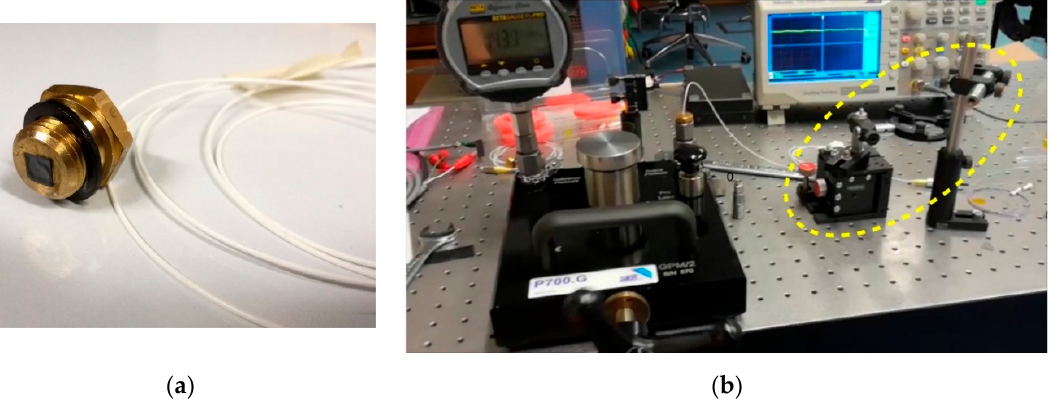
Figure 8. ( a ) Picture of a diamond-on-silicon membrane mounted on the brass holder and coupled to the SMF. ( b ) Picture of the experimental set-up used during high-pressure membrane characterization. On the left, the hydraulic test pump with the digital test gauge used for reference. On the right, the dotted circle indicates the micrometric x–y stage used for preliminary diamond-on-Si assembly on brass holder (see text).